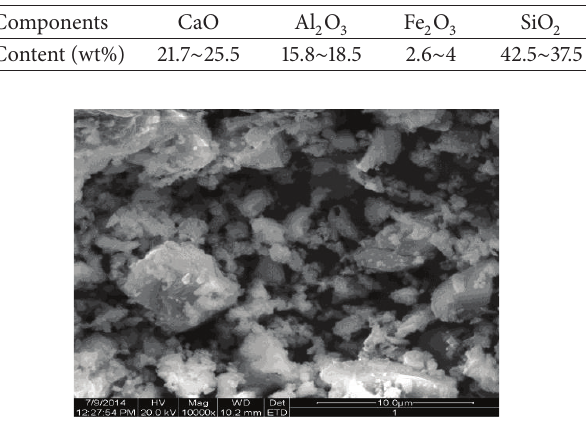
Figure 2: The SEM image of CWBP.